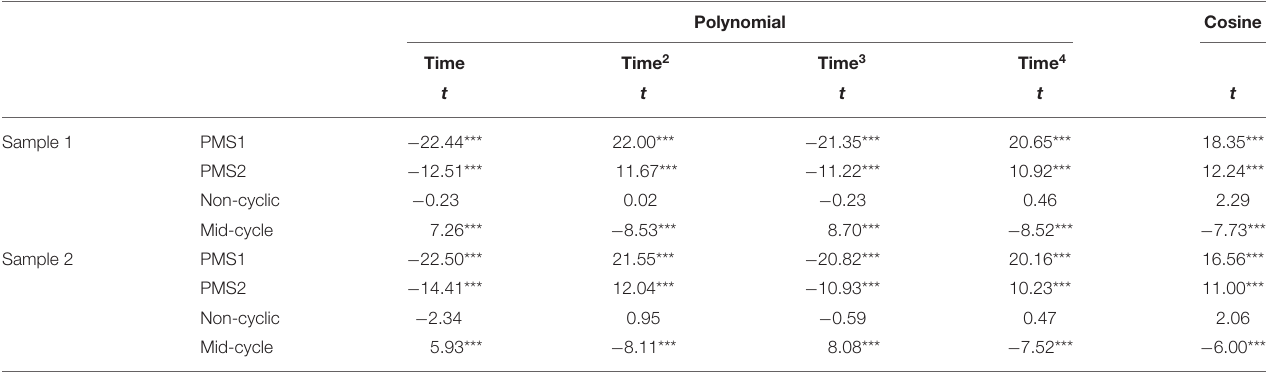
TABLE 2 | Regression coefficients indicating change in depression/anxiety across time, presented for each trajectory group separately, using polynomial and cosine regression analyses, including participant as a random factor. Polynomial